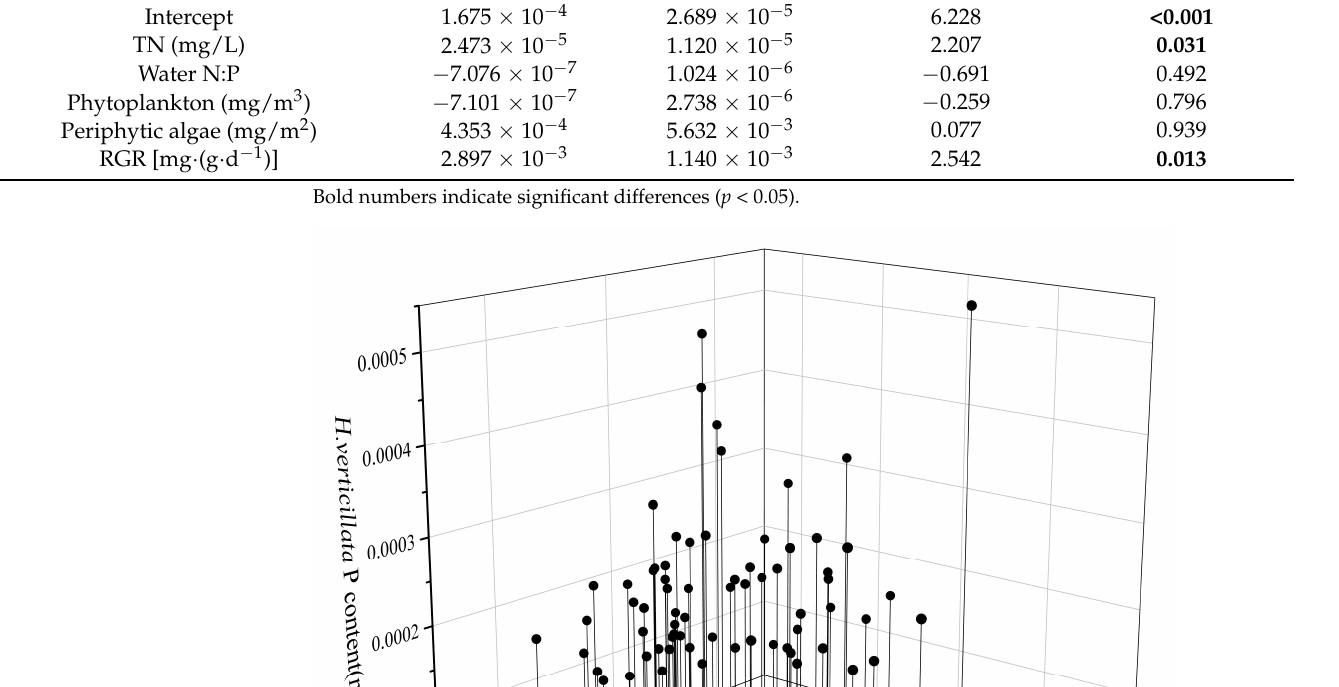
Table 4. Summary of the best model of the relationship between H. verticillata P and water N:P. Predictor Coefficient Std. Error